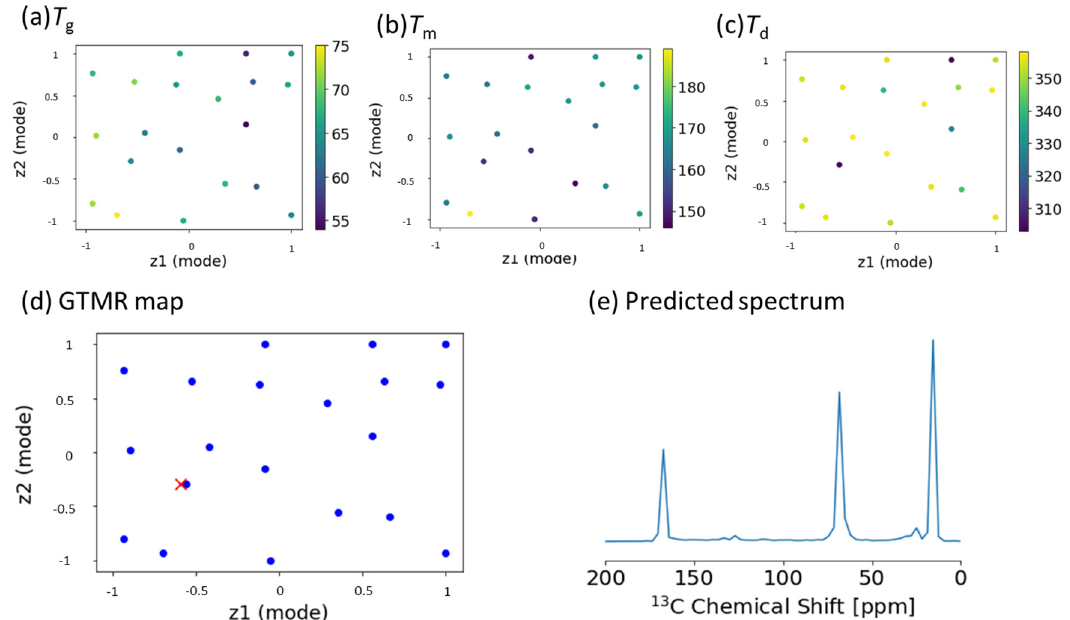
Figure 5. Application of GTMR for predicting NMR data from thermal properties in PLA. ( a – c ) T g , T m , and T d in data map. ( d ) Coordinates corresponding to the target thermal properties in data map. ( e ) Predicted 13 C CP-MAS spectrum using GTMR.